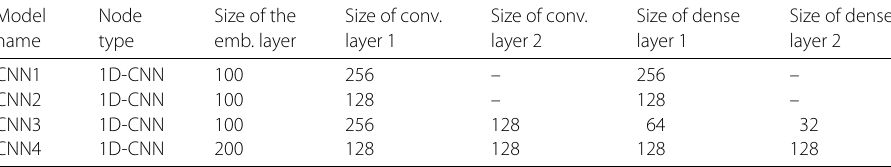
Table 14 Detailed composition (number of neurons) of the Convolutional Neural Networks Model name